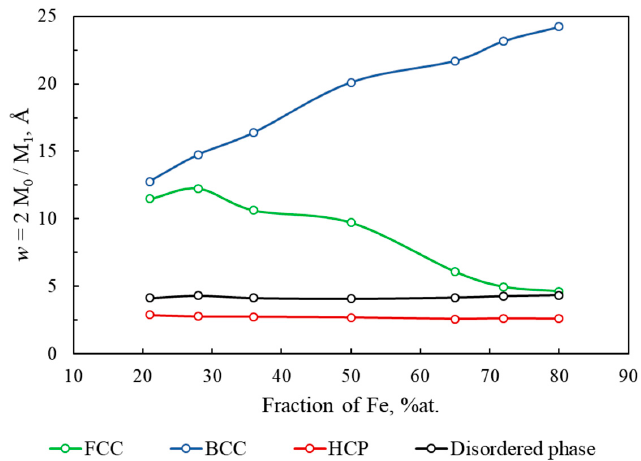
Figure 9. The dependence of mean thickness w ( X ) of the phase for fcc (green), bcc (blue), hcp (red) and disordered phase (black) on the iron fraction in the Fe–Cu nanocomposite.